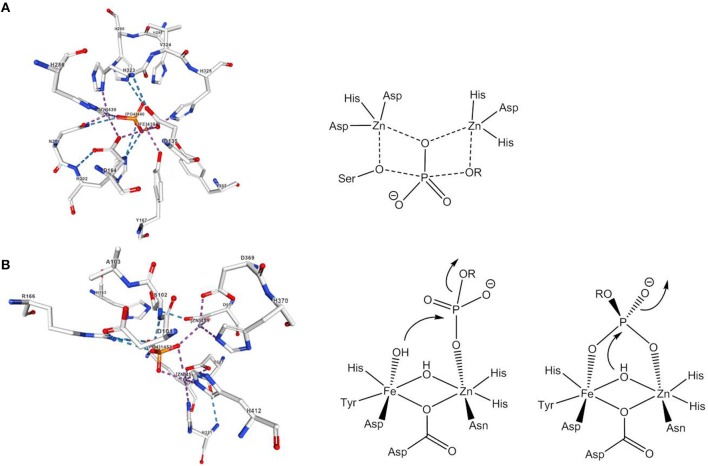
Active site and mechanism(s) of (A)
E. coli alkaline phosphatase and (B) red kidney bean PAP. The image of the dizinc(II) site complex with phosphate in (A) was created with the PDB 1KHL and associated publication (Le Du et al., 2002). The image of the active site complex with phosphate in (B) was created with the PDB 4KBP and associated publication (Klabunde et al., 1996). NGL Viewer (Rose et al., 2018) and RCSB PDB.